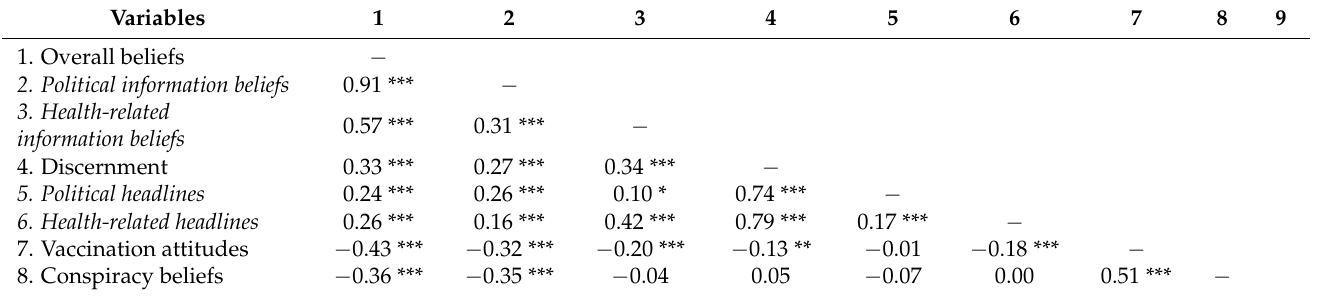
Table 2. Correlations between variables.